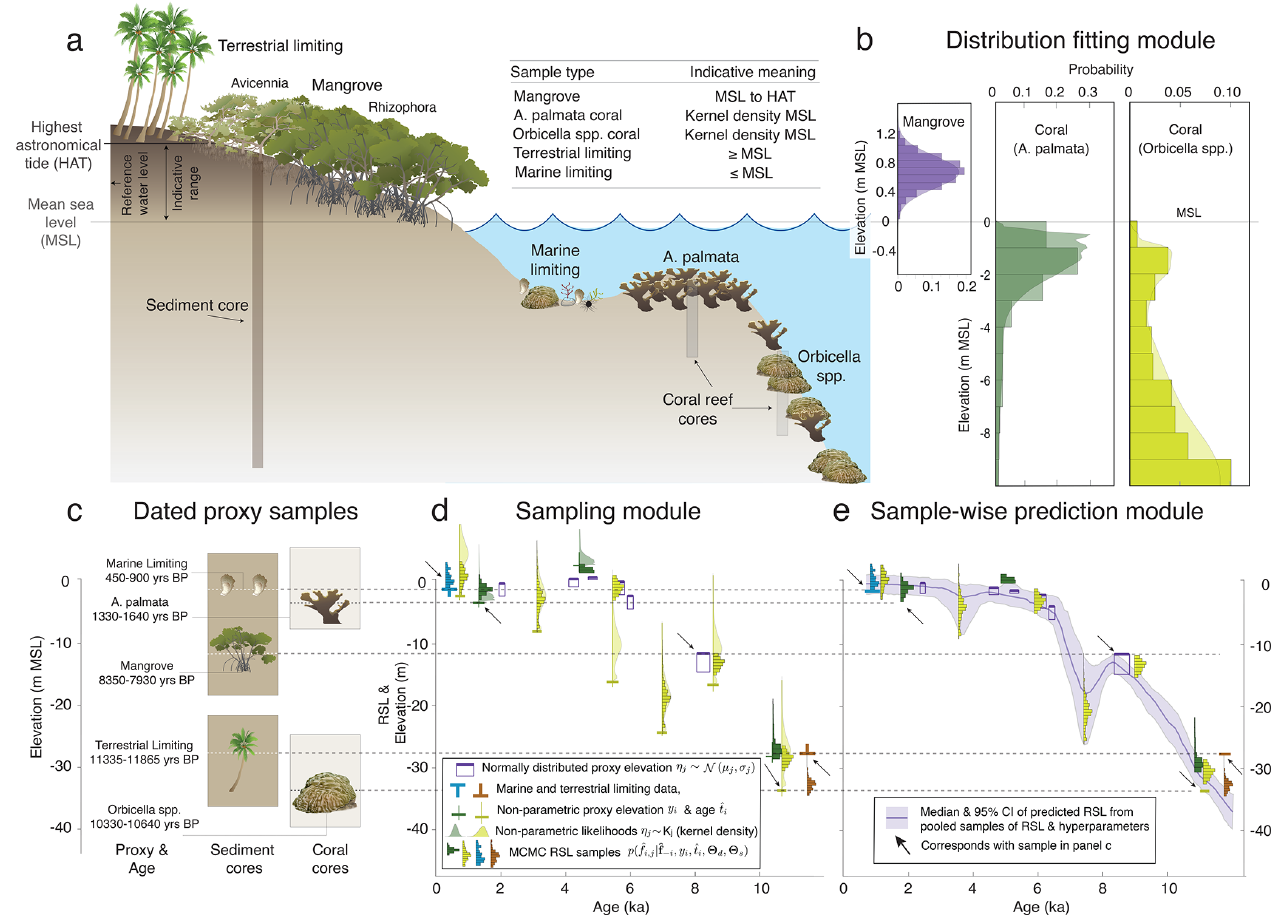
Figure 1. Schematic representation of the indicative meaning and a theoretical example of its application to reconstruct relative sea level (RSL) from radiocarbon-dated mangrove sediment and reef-crest cores: (a) the vertical distribution (indicative meaning) of mangrove and reef zones for the Caribbean region with respect to mean sea level (MSL) and highest astronomical tide (HAT); (b) the distribution-fitting module, which determines the likelihoods that will be used in the subsequent modules; (c) elevations of dated samples in theoretical cores; (d) the sampling module, which approximates the distribution of RSL at each point with proxy data by conditioning the Gaussian process (GP) prior with sampled hyperparameters on all other data. The result is multiple sets of noisy RSL samples paired with sampled hyperparameters. Note, for example, that some samples of noisy RSL are very different from their original likelihood distributions prior to conditioning on all other data. (e) The sample-wise prediction module, which takes an arbitrary number of samples (here, 10) from the posterior GP created from each paired set of RSL samples and hyperparameters from the sampling module. These samples are pooled to estimate RSL. Symbols courtesy of the Integration and Application Network (https://ian.umces.edu/symbols/, last access: 4 February 2022) of the University of Maryland Center for Environmental Science and https://www.fisheries.noaa.gov/species/mountainous-star-coral, last access: 4 February